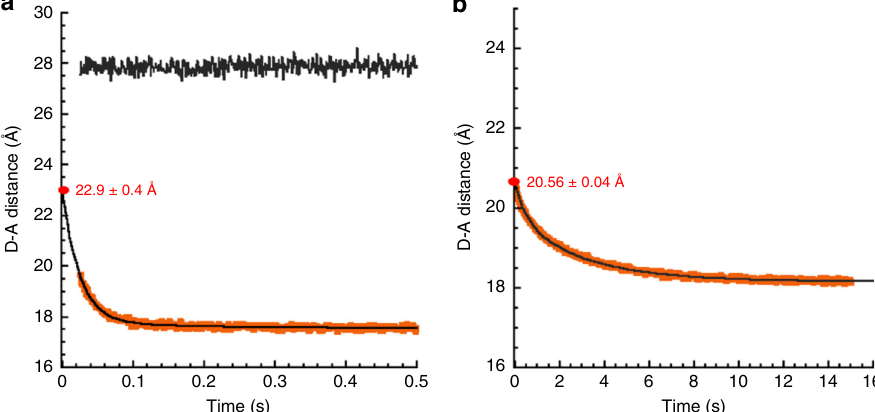
Fig. 2 Refolding kinetics of SH3 monitored by stopped- fl ow FRET. a The changes in the apparent distance between donor and acceptor (D-A distance), which was calculated from the FRET ef fi ciency (Supplementary Fig. 5d), during SH3 refolding in the absence of Spy (shown as solid orange line). The solid black line shows the D-A distance when SH3 is in buffer containing 9.5 M urea, which was calculated from the FRET ef fi ciency (Supplementary Fig. 5e). b The changes in D-A distance for SH3 refolding in the presence of Spy (160.7 µ M dimer after mixing), which was calculated from the FRET ef fi ciency (Supplementary Fig.